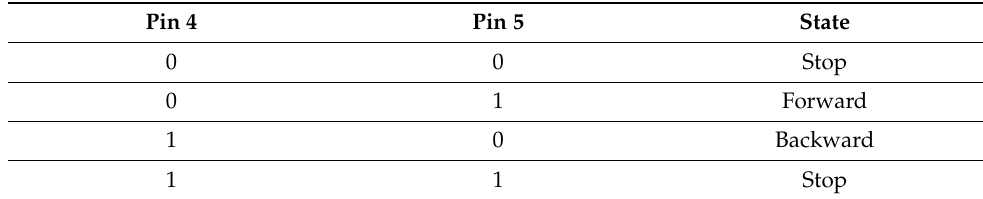
Table 3. DC–DC converter state based on pin values.